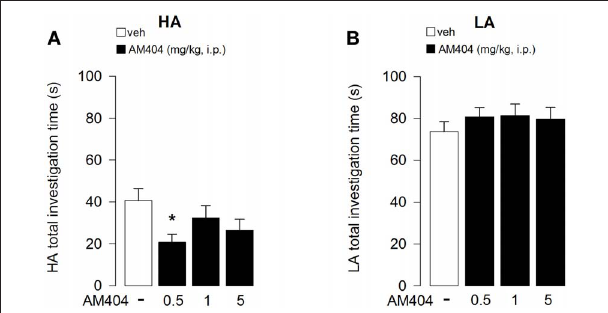
FIGURE 7 | Effects of AM404 administration on spatial change discrimination in rats exposed to high arousal (HA) or low arousal (LA) conditions. Spatial change discrimination index of rats exposed to HA (A) or LA (B) conditions. Tim spent in contact with Displaced (DO) and Non-Displaced (NDO) Objects in session 4 minus the mean time spent in contact with the same object in session 3. A discrimination index was obtained by subtracting the NDO value to DO value. Data are expressed as mean ± SEM. (HA: veh n = 10, 0.5mg/kg n = 11, 1mg/kg n = 10, 5mg/kg